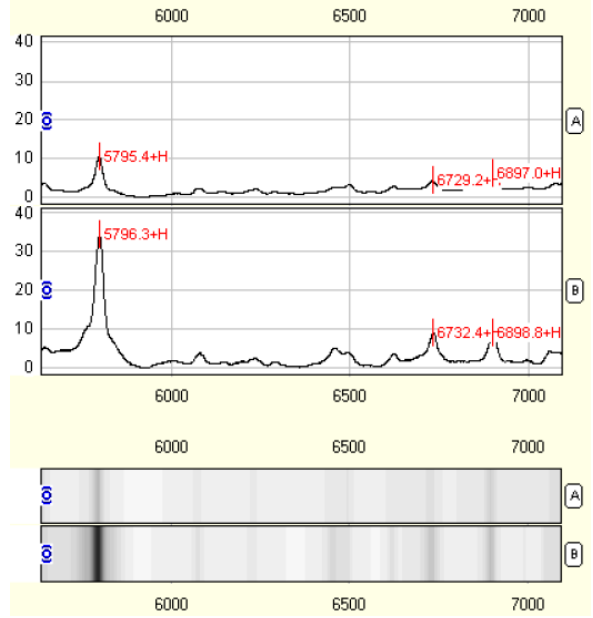
Figure 3. Proteomic analysis of HSC-T6 cells treated with a combination of taurine, EGCG and genistein. We performed a proteomic analysis of taurine, EGCG and genistein-treated HSC-T6 cells ( A ) and control HSC-T6 cells ( B ). Representative protein peaks and gel views of the peaks which positively correlated with fibrosis with a m / z 5798.33, 6735.19 and 6896.73 are